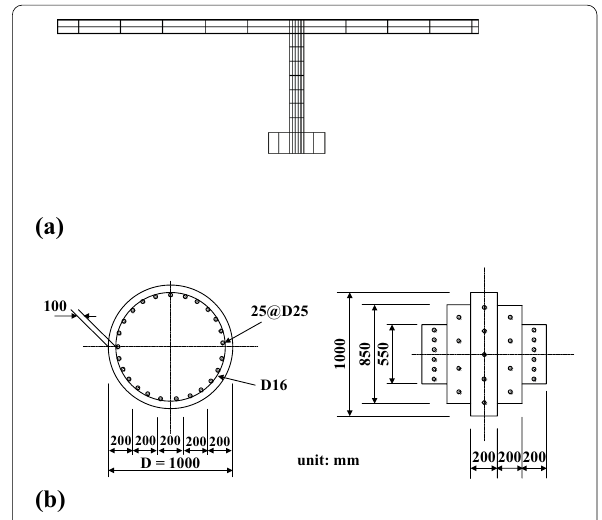
Fig. 9 Finite‑element model for two‑span simply supported reinforced concrete bridge: a finite‑element mesh for two‑span bridge and b transformation of a circular column to an idealized equivalent rectangular column.